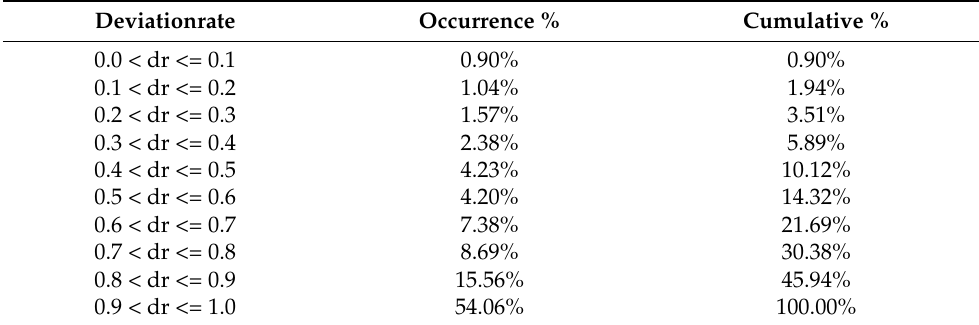
Table 1. Left column: intervals of the deviation rate (between 0 and 1); center column: percentage of occurrence or percentage of planes in the test set that fall within each interval considered; right column: cumulative percentage or percentage of planes in the test set whose deviation rate is less than or equal to the upper value of the range